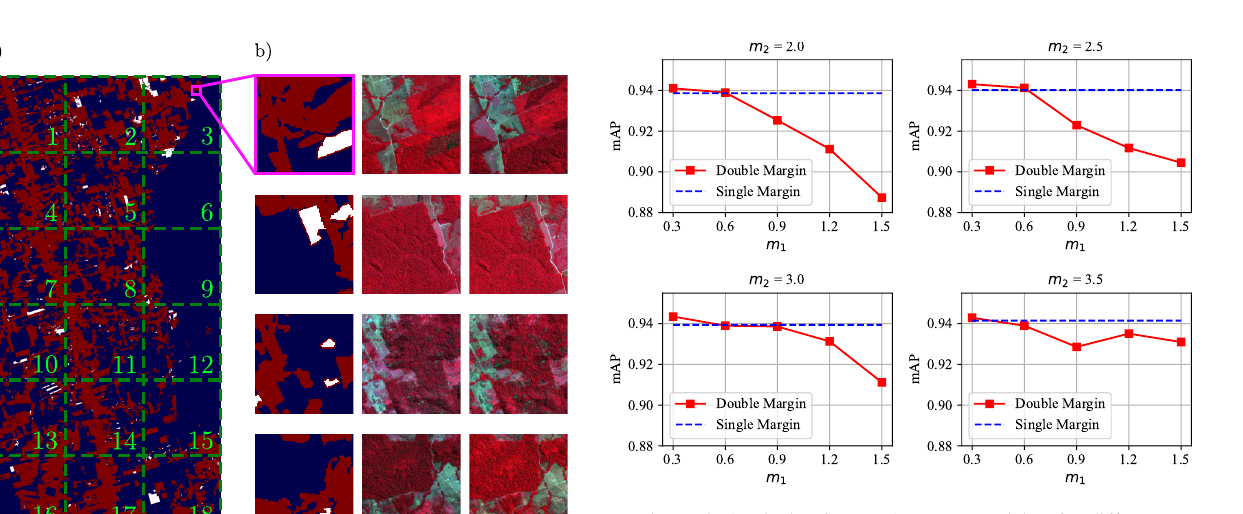
Figure 4. Analysis of mean Average Precision for different margins used in the WDMC loss function . Dashed lines indicate Figure 3. Overview of dataset used in the experiments. In a), a reference for m 1 = 0 . Reference of Amazon deforestation between 2018 and 2019. Blue color represents non-deforested areas, white color represents deforested areas, and red color indicates past deforested areas and current deforestation borders. In b), four examples of patches used in training phase; from left to right: label, image in 2018 and image in 2019, both represented in the NIR-G-B composition.